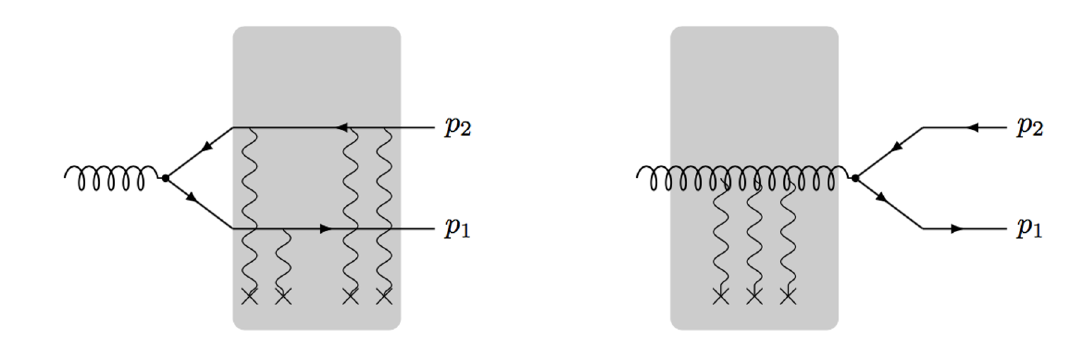
Figure 2 . Quark-pair production amplitude in the CGC formalism, in which the pair is radiated from the gluon before (left) or after (right) the multiple interactions with the gauge fields in the target represented by wavy lines. Each propagating parton picks up a Wilson line, implying 2-, 3-, and 4-point Wilson line correlators after